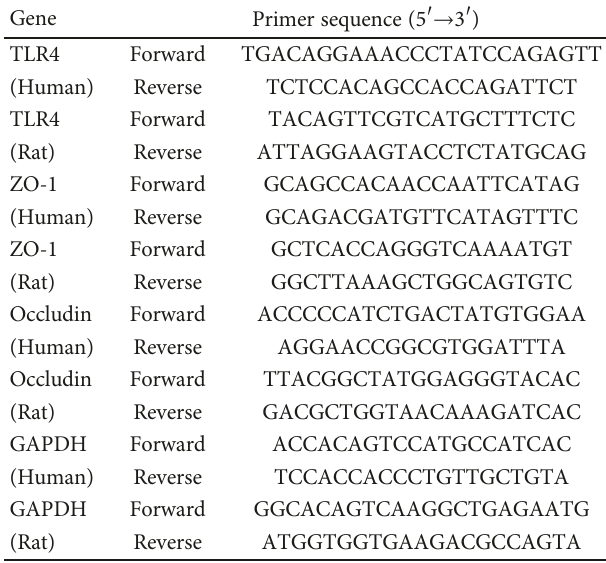
Table 1: The primer sequence for